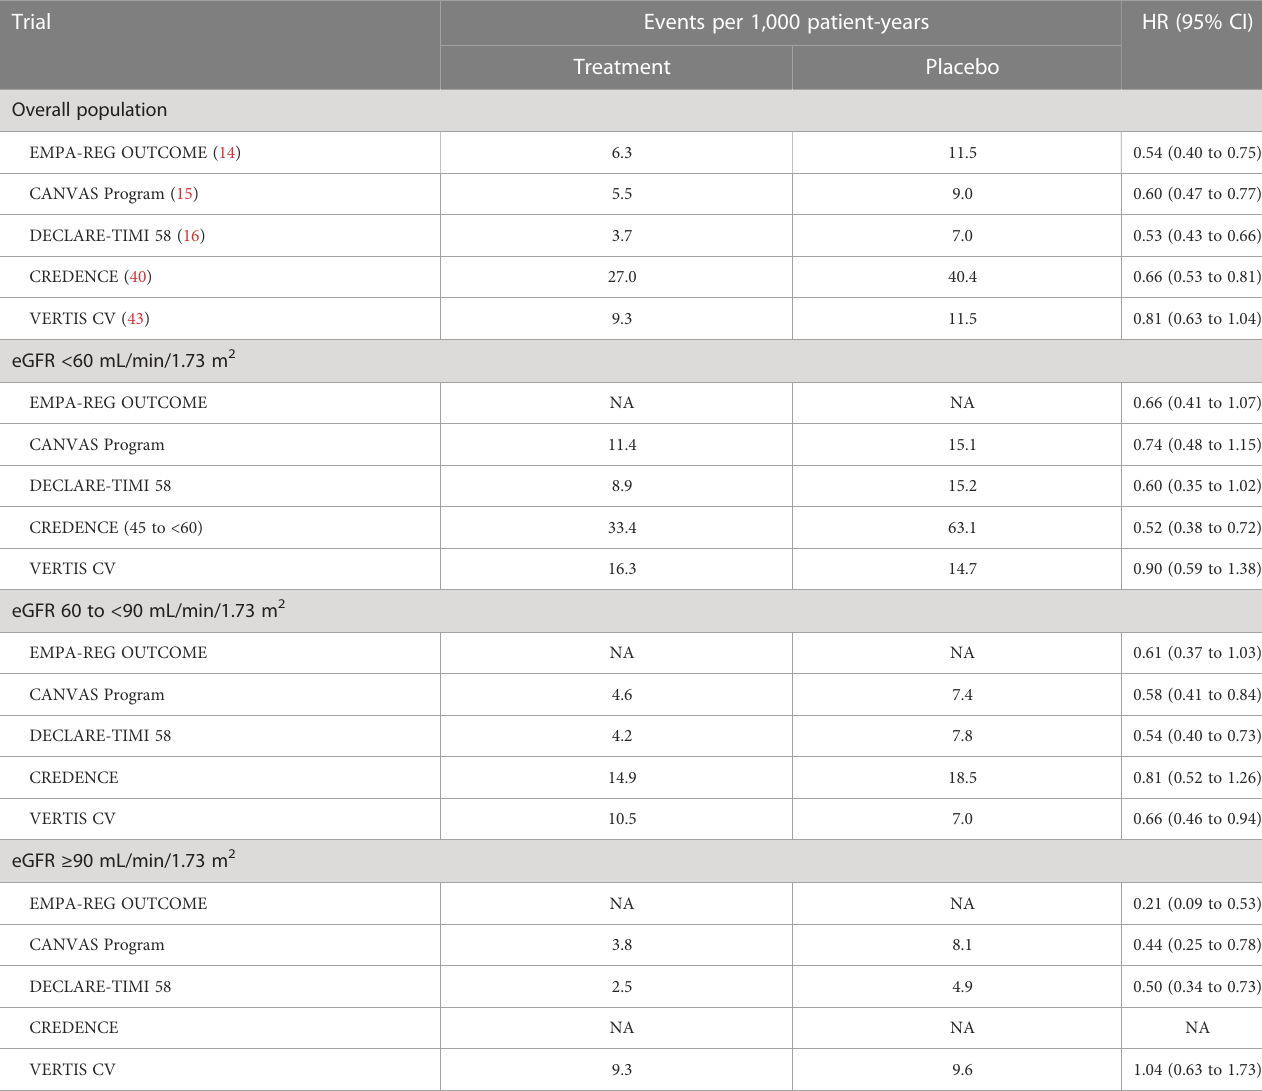
TABLE 2 Renal composite outcomes (worsening eGFR, end-stage renal disease, or renal death) according to renal function among patients with type 2